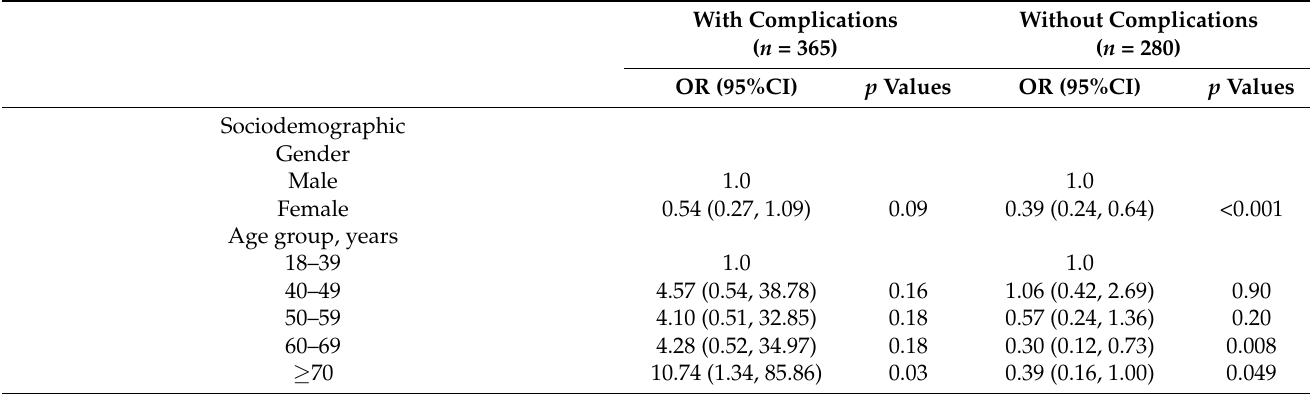
Table 3. Comparing COVID-19 vaccination uptake and perceptions related to COVID-19 vaccination between diabetes mellitus (DM) patients with and without